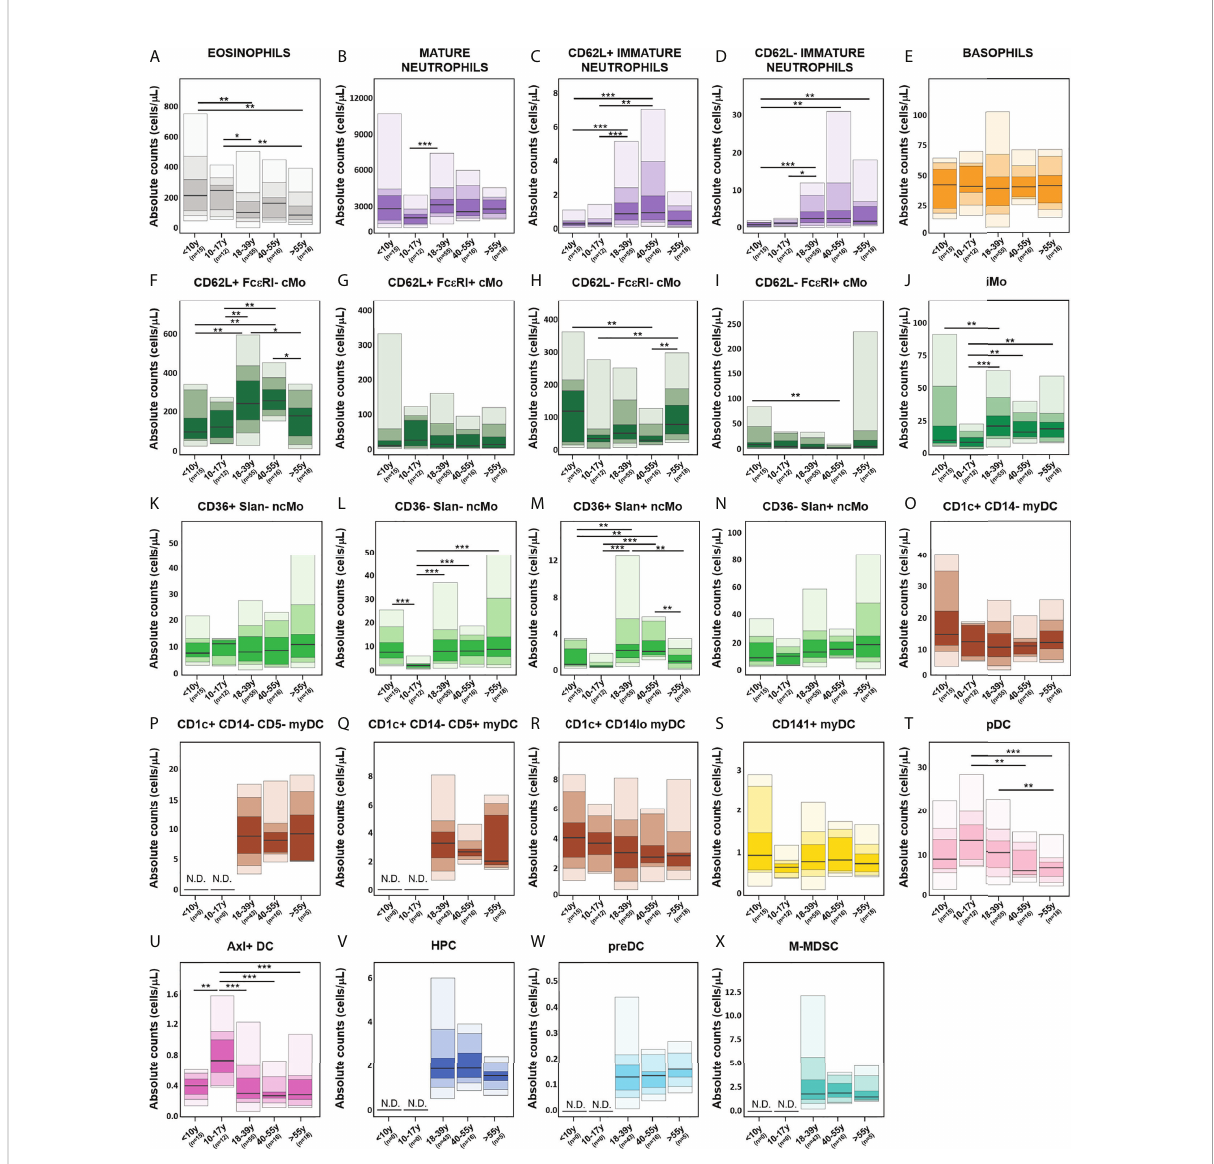
FIGURE 9 Age-related distribution of innate myeloid cell (IMC) populations identi fi ed using the EuroFlow IMC tube, based on the evaluation of blood samples from 116 healthy individuals. Reference ranges for all IMC populations identi fi ed with the innate myeloid (IMC) tube [granulocytic cells (A – E) , monocytic populations (F – N) , dendritic cell (DC) populations (O – U) , hematopoietic precursor cells (HPC) (V) , preDC (W) and monocytic myeloid-derived suppressor cells (M-MDSC) (X) ] in different age categories. Minimum, percentiles 10, 25, 50 (median), 75 and 90, and maximum values are shown. Statistically signi fi cant differences were evaluated using a Kruskal-Wallis test and false discovery rate (FDR) of 5% to correct for multiple comparisons (* p-value < 0.05; ** p-value < 0.01; *** p-value < 0.001). cMo, classical monocytes; iMo, intermediate monocytes; ncMo, non-classical monocytes; DC, dendritic cells; myDC, myeloid dendritic cells; pDC, plasmacytoid dendritic cells; HPC, hematopoietic precursor cells; M-MDSC; monocytic myeloid-derived suppressor cells; N.D., not